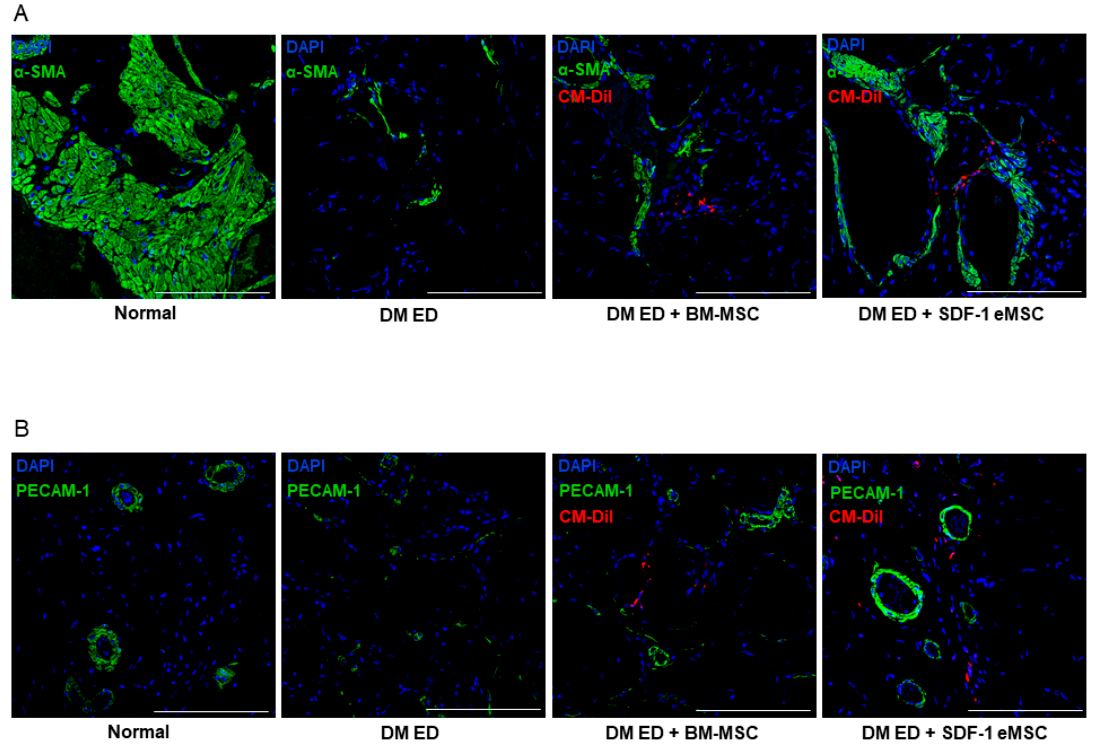
Figure 3. Representative images of immunofluorescence staining in the corpus cavernosum after treatment with mesenchymal stem cells (MSCs). ( A ) Representative images of α -SMA staining for each group. Red indicates MSCs, green represents α -SMA, and blue represents cell nuclei. Scale bar: 100 µ m. Original magnification: × 200; ( B ) Representative images of PECAM-1 staining for each group. Red indicates MSCs, green is PECAM-1, and blue represents cell nuclei. Original magnification: ×200.